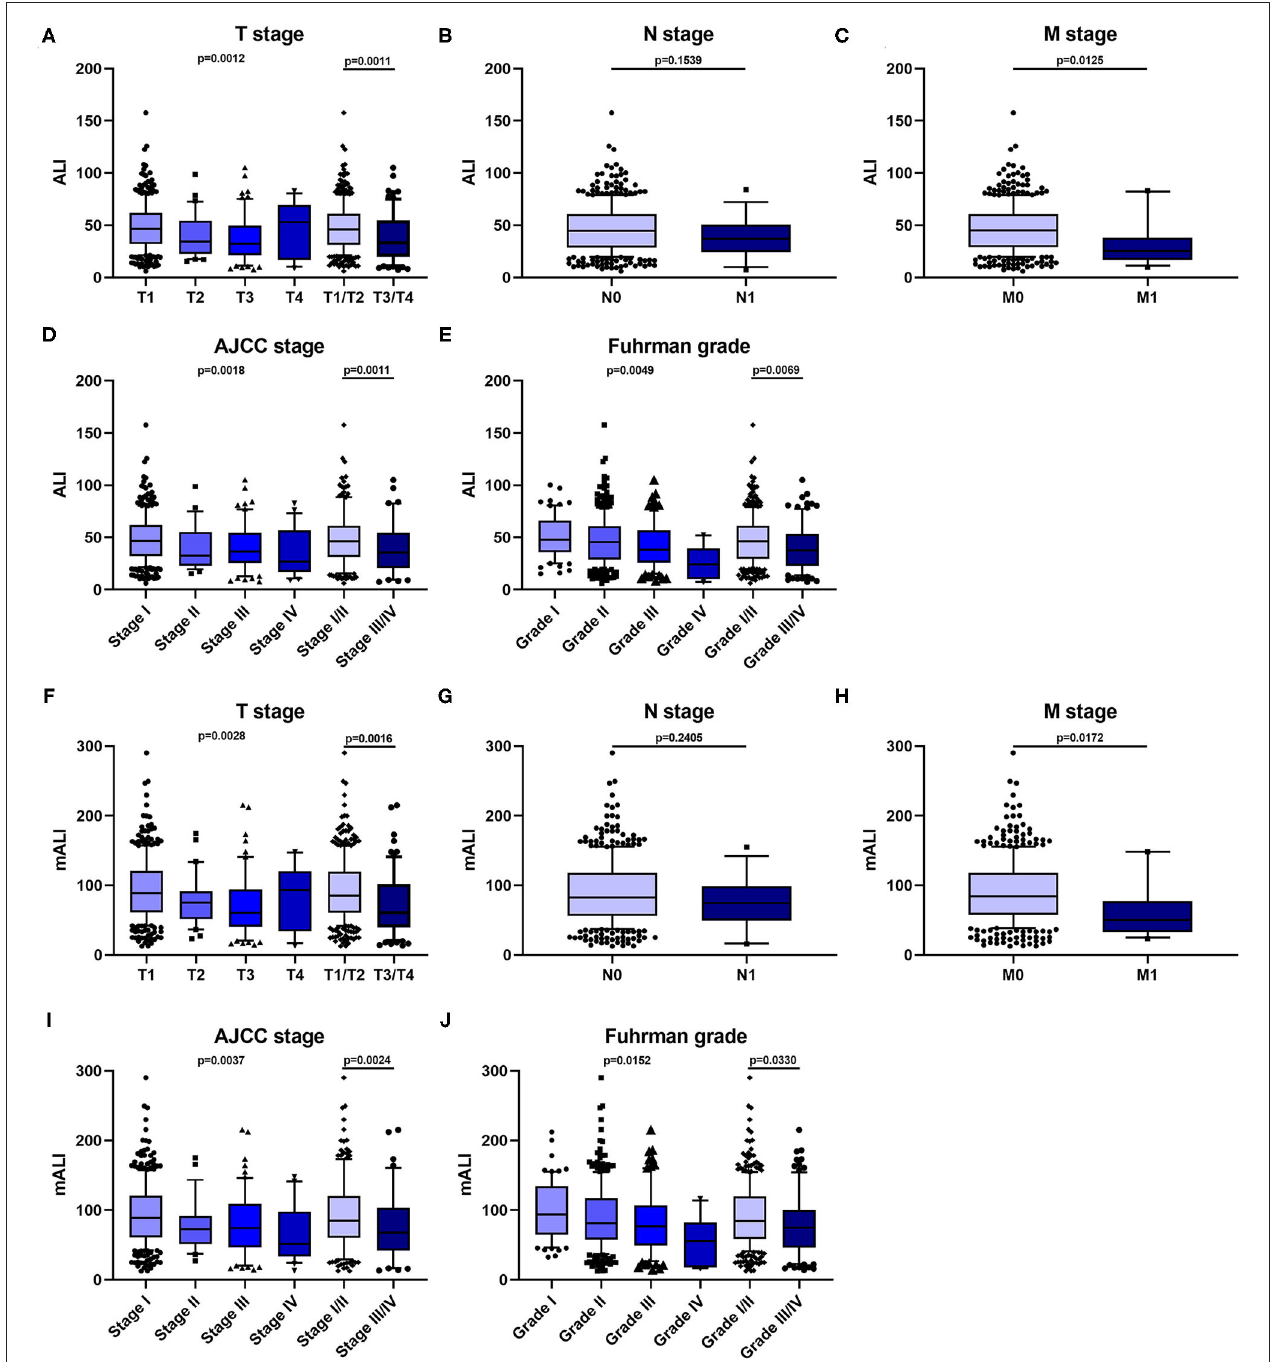
FIGURE 2 | Relationship between patients’ clinical characteristics and ALI, mALI. (A–E) Levels of ALI in different T-stage (A) , N-stage (B) , M-stage (C) , AJCC stage (D) , and Fuhrman grade (E) . (F–J) Levels of ALI in different T-stage (F) , N-stage (G) , M-stage (H) , AJCC stage (I) , and Fuhrman grade (J) . ALI, advanced lung cancer inflammation index; mALI, modified advanced lung cancer inflammation index.